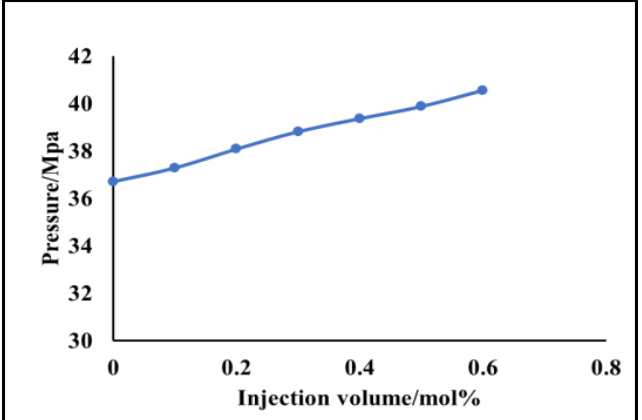
Figure 8. Relative volume versus pressure at different CO 2 injection molar quantity.